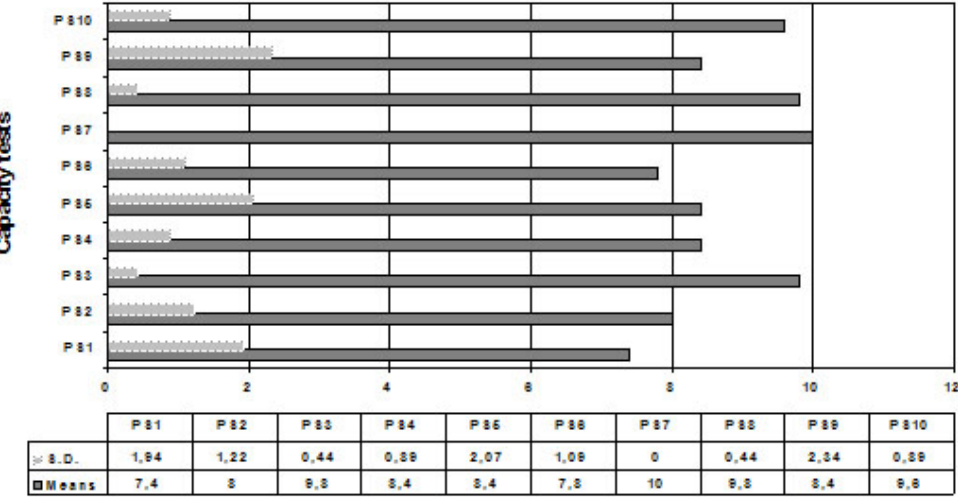
Figure 4. Self-Assessment Test